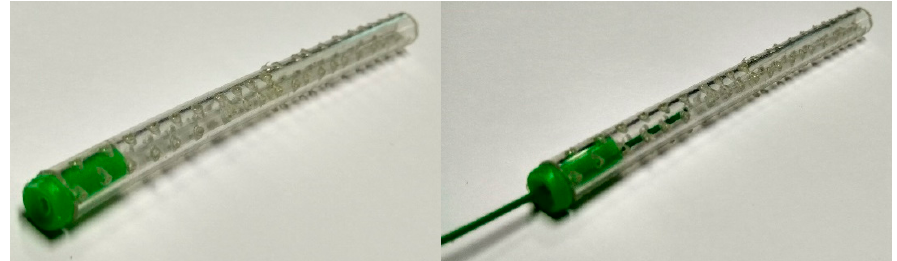
Figure 2. Optical sensor’s polyvinylchloride (PVC) drilled protective cap.